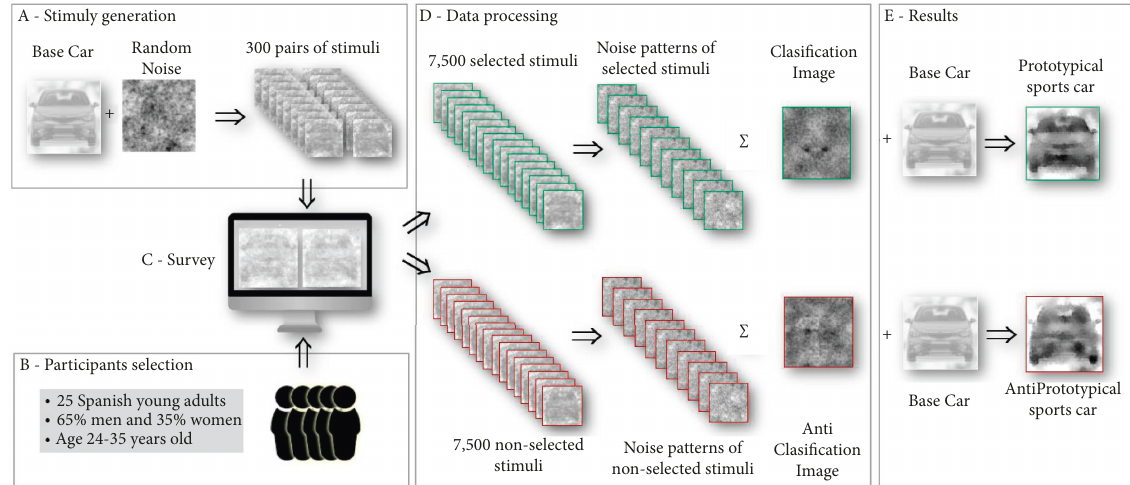
Figure 1: Five steps of the NBRC task to obtain the prototypical and antiprototypical images of a sports car.